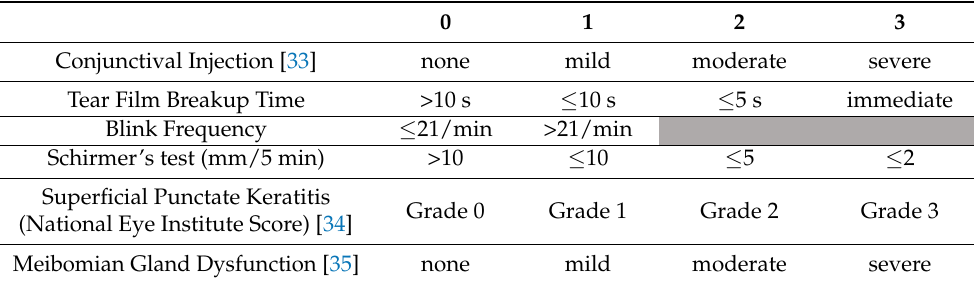
Table 1. Clinical score of the dry eye, applied for each eye separately *, grey color indicating non- applicable